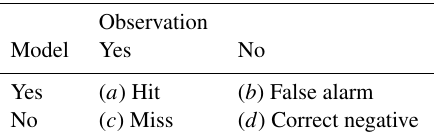
Table 3. The 2 × 2 contingency table describing each model out- come. The model outcomes a, b, c and d then become the variables in Eqs.